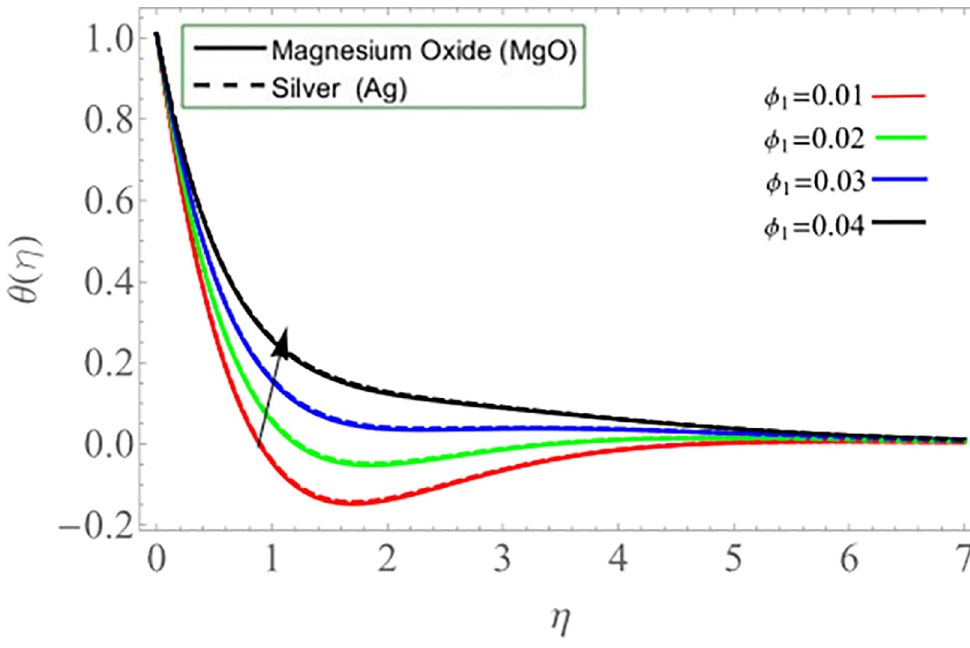
Fig 3. https://doi.org/10.1371/journal.pone.0254457.g003 Fig 10 explored the consequences of Prandtl number Pr on energy profile. It can be noticed that the temperature declines by the action of Prandtl number. Physically, the action of Prandtl number directly affect the dynamic viscosity and specific heat capacity of fluid, as result the